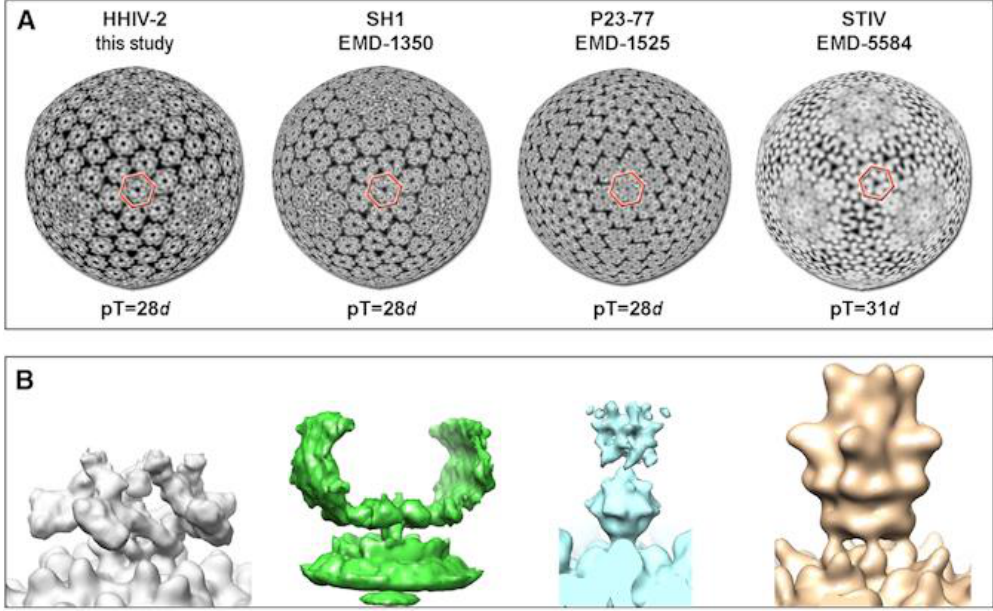
Figure 6. Icosahedral membrane-containing viruses with conserved capsid elements but highly divergent host recognition structures. (A) Radial cross sections at the base of the conserved pseudo-hexameric capsomers (red indicates the base of one capsomer). The capsomers of HHIV-2, SH1, and P23-77 are composed of six vertical single β -barrel MCPs, whereas STIV represents an example that uses instead three vertical double β -barrel MCPs. EMDataBank accession numbers are provided. HHIV-2 is deposited under the accession number of EMD- 3109 (“this study” here refers to [39]). (B) The five-fold vertex complexes of these four viruses (not to scale). Reproduced with